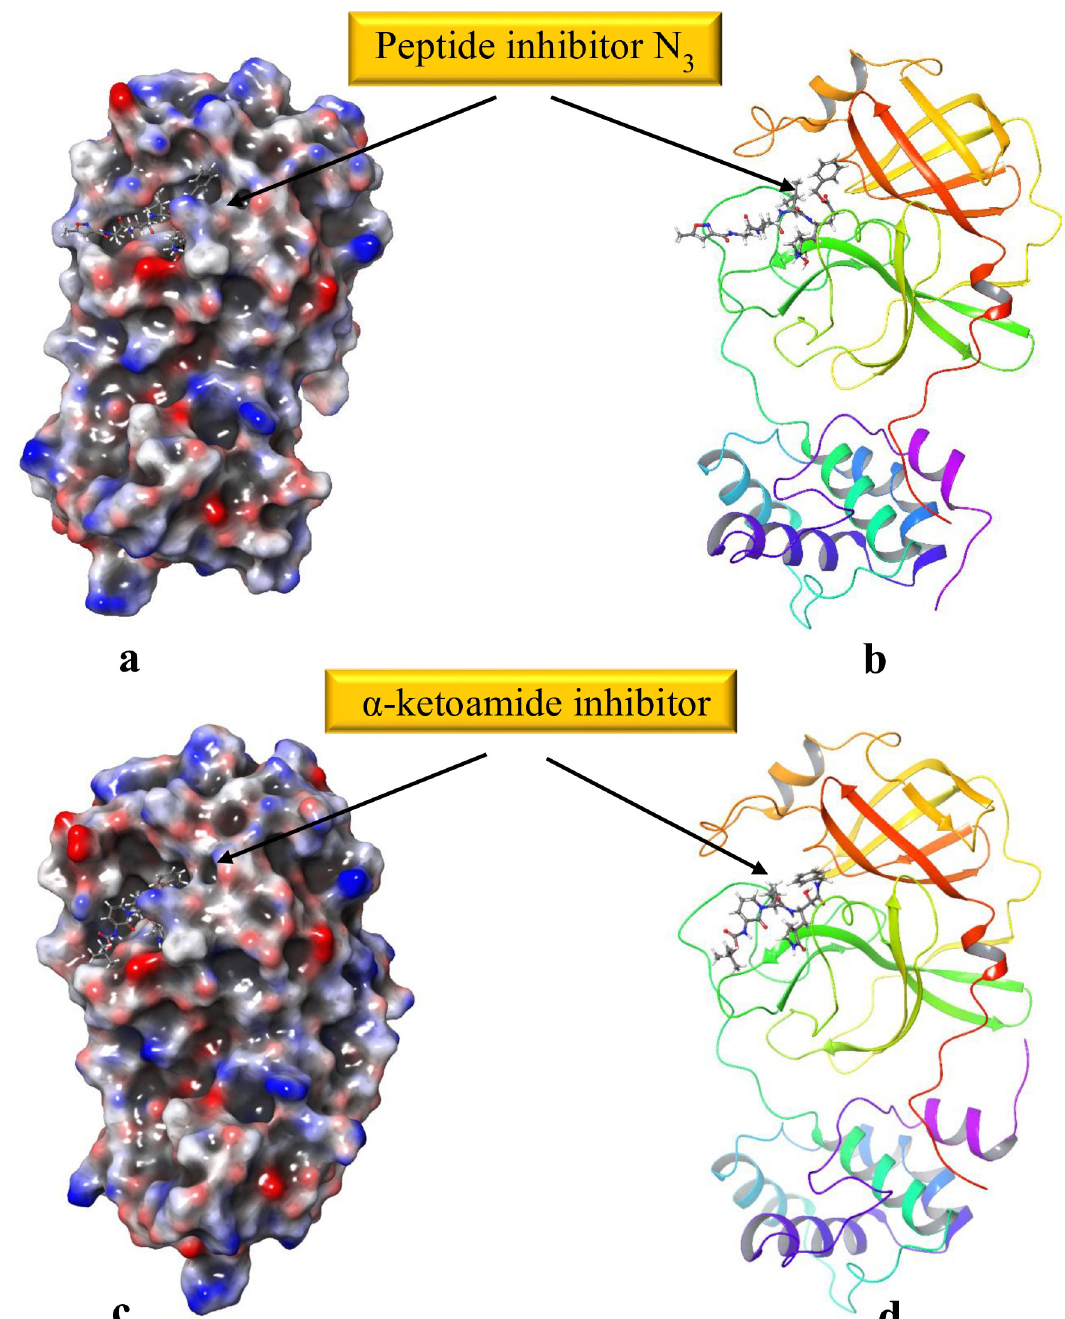
Fig 1. 3CL pro hydrolase prepared via Protein Preparation Wizard , Maestro. H-bond network optimized and geometry minimized structures of 2019-nCOV 3CL hydrolase (Mpro) PDB ID: (a) , and (b) 6LU7, (c) , and (d) 6Y2F represented as 3D molecular surface and ribbon